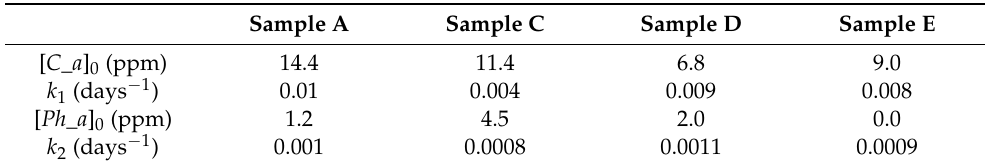
Table 6. Initial concentration of chlorophyll a and pheophytin a, [ C_a ] 0 (ppm) and [ Ph_a ] 0 (ppm), and two kinetic constants, k 1 (days − 1 ) and k 2 (days − 1 ), obtained from the fitting of experimental data reported in Figure 11 by using Equations (11) and (12) of the selected fresh EVOO samples (label A, C, D, and